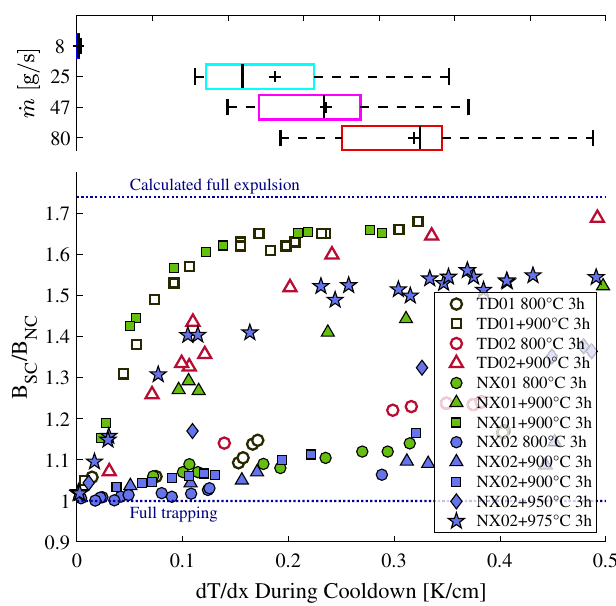
FIG. 4. Bottom: Flux expulsion behavior measured by B =B ð dT=dx Þ in measurements of four single cell SC NC 1.3 GHz cavities made from the production material for the LCLS-II main linac. Measurements show that the baseline cavity processing parameters (circles) produce near full trapping behav- ior for all four cavities. But high temperature treatment of the cavities allows them to achieve near-full expulsion when apply- ing thermal gradients in the range of 0 . 2 – 0 . 3 K = cm during cooldown. Top: Comparison to thermal gradients achieved as a function of mass flow in the prototype cryomodule from Fig. 3. The lowest mass flow cooldown of the pCM would be expected to result in nearly full trapping for all cases. The others would result in different levels of flux expulsion depending on the heat treatment of the